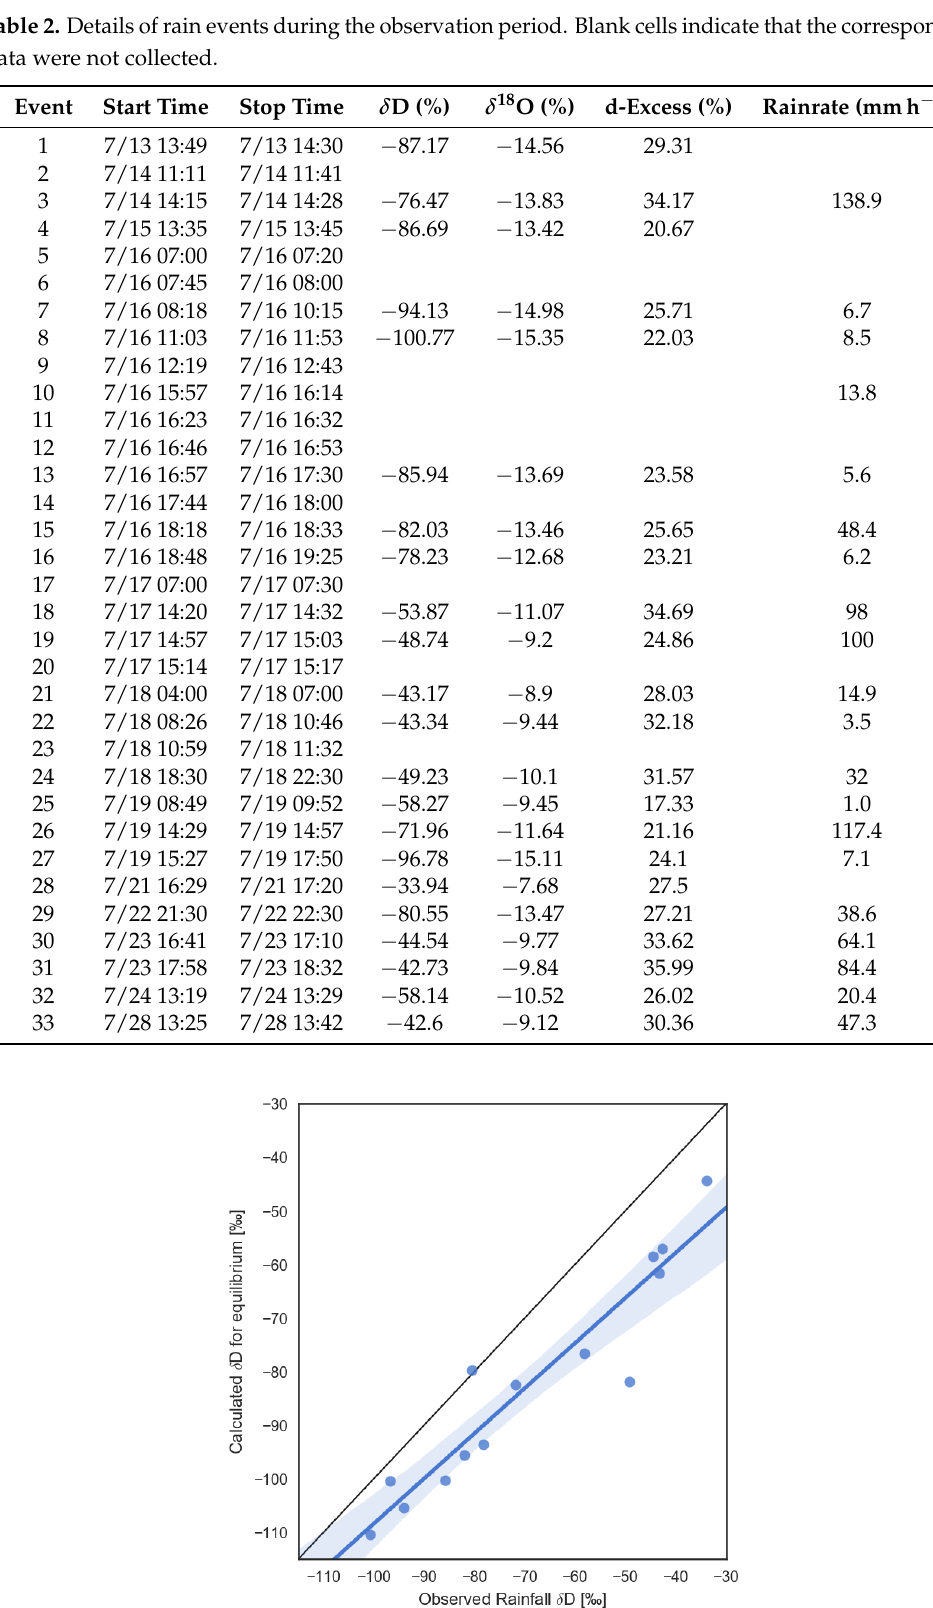
Figure 5. Comparison between theoretical equilibrium rainfall δ D (calculated based on observed vapor δ D and temperature) and observed rainfall δ